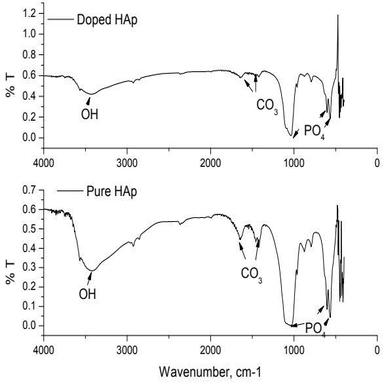
FTIR pattern of pure and doped HAp powder